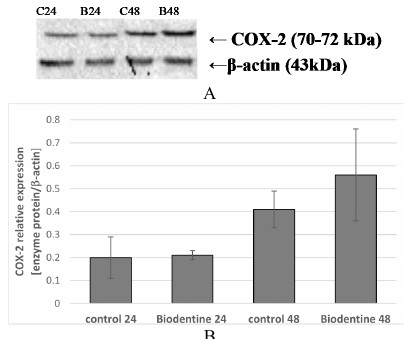
Figure 9. COX-1 protein expression in macrophages. Enzyme protein expression (70 kDa) was determined using Western blot method. Representative Western blots of COX-1 protein ( A ) and densitometric analysis of COX-1 protein normalized to β -actin ( B ) in macrophages were shown. Cells were cultured for 24 h (B24) and 48 h (B48) in RPMI medium with 10% FBS with Biodentine TM , after incubation the cells were harvested by scraping and protein concentration was measured. Control cells were incubated in RPMI medium with 10% FBS for 24 h as control 24 (C24) or for 48 h as control 48 (C48). Experiments were conducted as three separate assays. There were no statistically significant di ff erences between the studied groups, p ≤ 0.5 (U-Mann Whitney